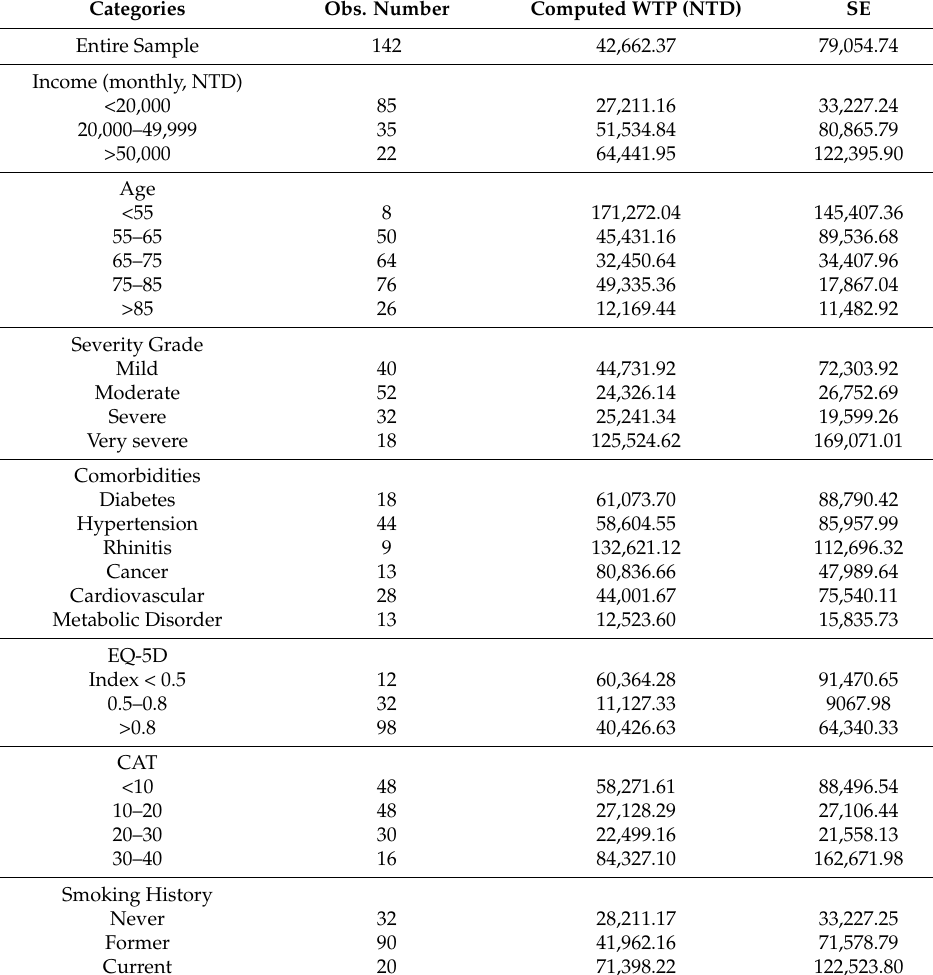
Table 6. Simulated WTP for subjects in different target